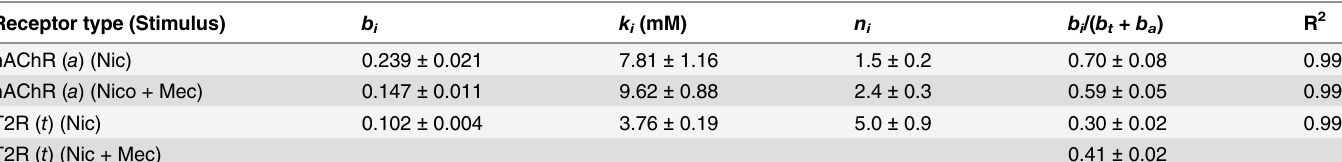
nicotine represents the output of both T2R and nAChR bitter taste receptors. The response in TRPM5 KO mice represents the nAChR component alone, and the T2R component is the mean of the response (WT-KO) difference and the ((WT + Mec)-(KO + Mec)) difference. In Fig 1A, 1B and 1C the CT response functions show positive cooperativity as the nicotine concentration increases above zero and a tendency toward saturation with increasing nicotine concentration. These properties can be represented quantitatively for each receptor class by the Hill equation as follows: b c n i ¼ r i k in þ c n